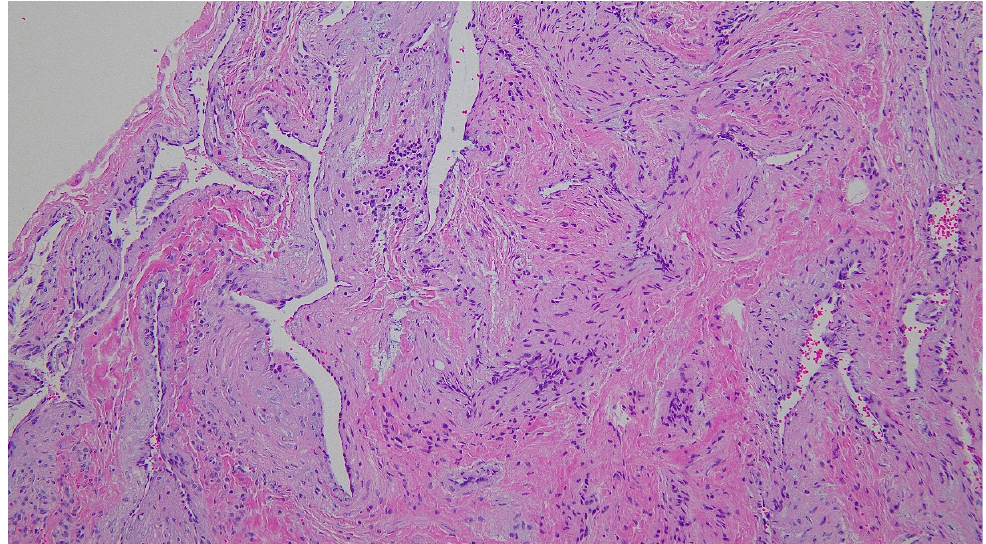
Figure 2. On brain computed angiography, an enhanced mass about 0.5 × 0.5 cm in size with soft tissue density was revealed at the helix of the right auricle. ( a ) Through neck magnetic resonance imaging (MRI), the mass at the helix of the right auricle was revealed with low signal intensity in T1-weighted images ( b ) and high signal intensity in T2-weighted images. ( c ) With suspicion of vascular tumor, surgical excision was planned upon patient request.